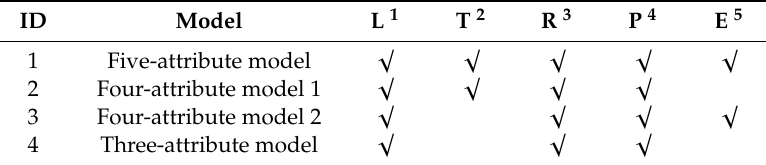
Table 2. Di ff erent methods involving combinations of models.